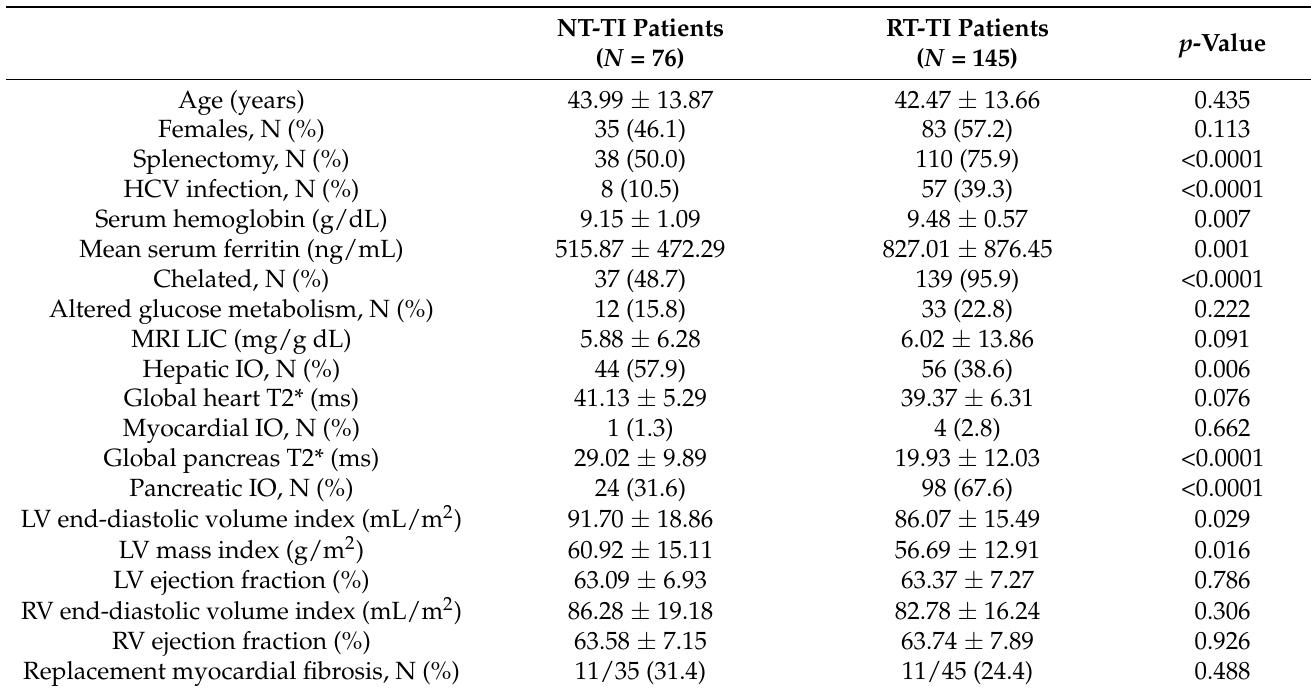
Table 1. Comparison of demographic, clinical, and MRI data between nontransfused and regularly transfused and thalassemia intermedia